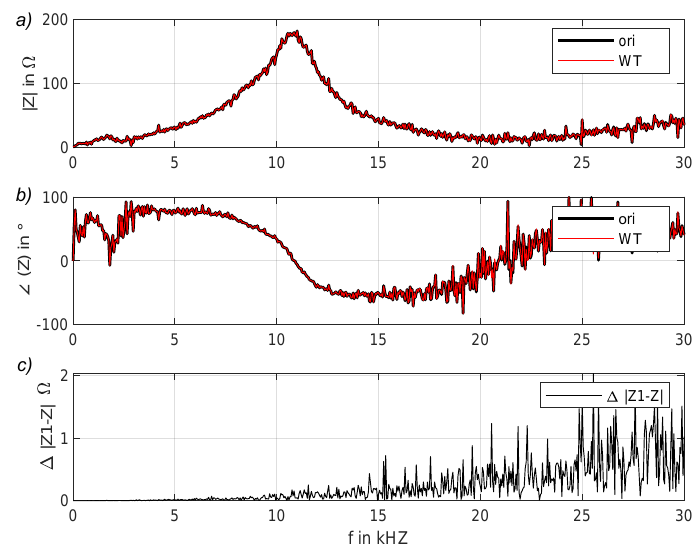
Figure 10. Impedance measurement results of the original (ori = original dataset and their impedance Z 1 ) and decompression results using WT (WT = WT decompressed dataset and their impedance Z ). The absolute impedance | Z | ( a ), the impedance angle ∠ ( Z ) = ϕ Z ( b ), and the absolute deviation ∆ | Z 1 − Z | ( c ) over the frequency f are shown.